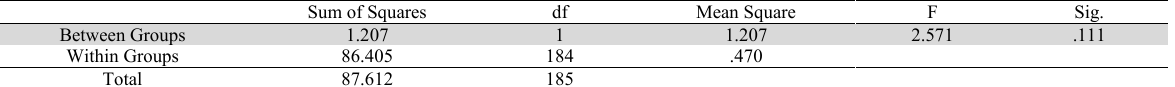
Result of testing of differences age on teacher’s behavioral intention of using information technology in lectures Test of Homogeneity of Variances